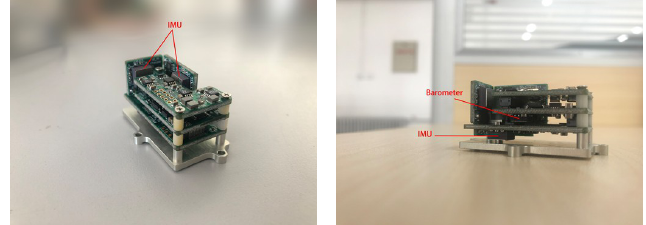
Figure 16. MEMS (microelectromechanical systems)-IMU, the position of IMU and barometer have been pointed out. Table 6. Information of the subject.